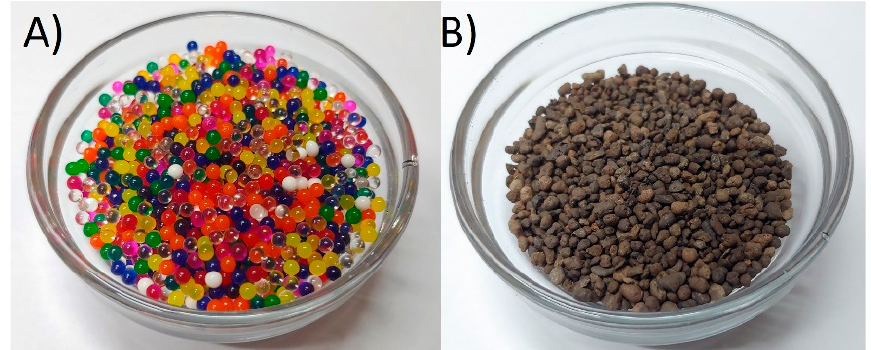
Figure 10. Particles used in the investigations: ( A ) polymer balls, ( B ) expanded clay.